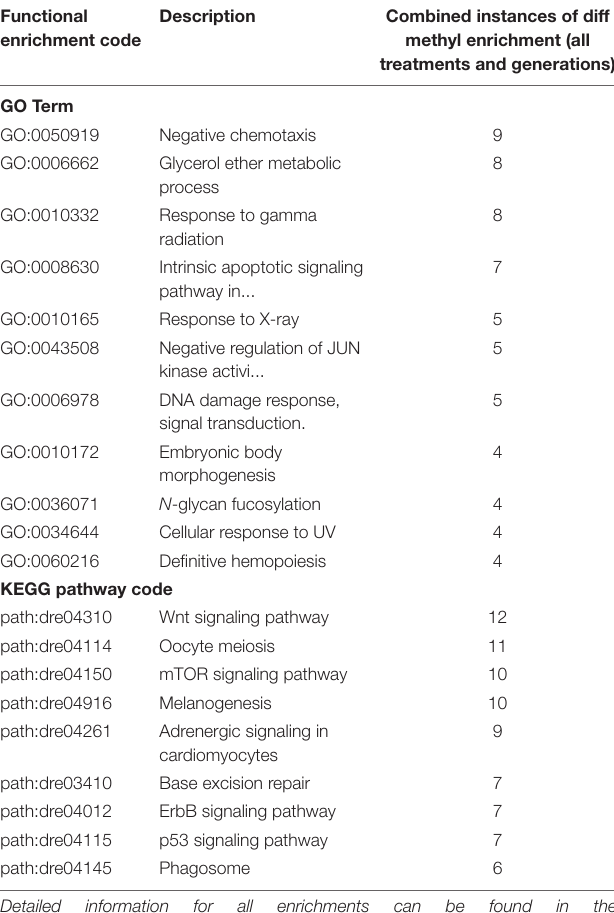
TABLE 1 | Most frequently detected functional analysis enrichments considering gene region (promoter and gene body) directional differential methylation relative to the control (hyper, hypo), treatment (Bif, EE2, Levo, Tren), and generation (F0, F1, F2) for Gene Ontology (GO) terms and Kyoto Encyclopedia of Genes and Genomes (KEGG) pathway